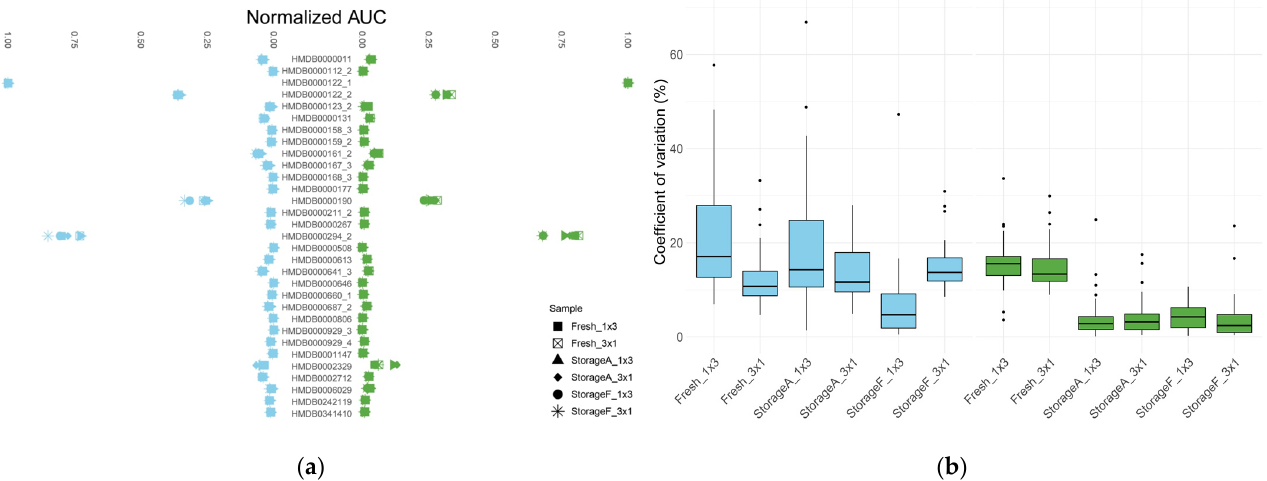
Figure 2. The consideration of various options for injecting a sample into the system: ( a ) normalized areas under the curves (AUCs) of chromatographic peaks of metabolites under study; ( b ) locality and spread of coefficient of variations calculated for metabolite signals. We compared the abundance of metabolites’ derivatives immediately after sample preparation (boxes with the “Fresh” prefix) and after a day of storage (boxes with the “StorageA” and “StorageF” prefixes in the case of storage at room temperature and in the refrigerator, respectively). Different injection schemes were also examined: three subsequent injections from the same vial or each technical repetition obtained from an intact vial, “3 × 1” and “1 × 3” postfixes, respectively. The blue boxes refer to the samples, during the injection of which the syringe was washed with methanol and the green ones—with pyridine. The black dots on the graph represent outliers.